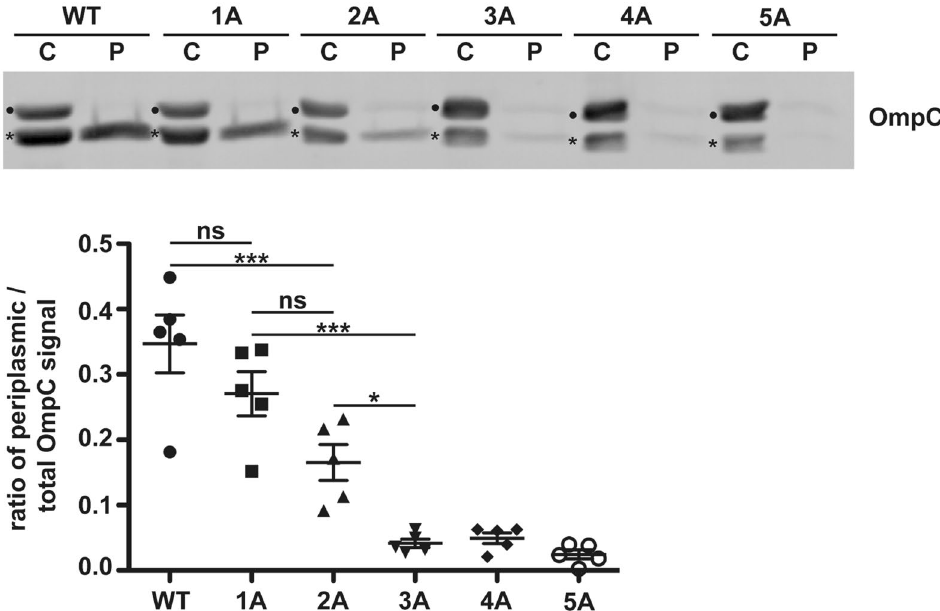
Figure 4. SecY-mediated translocation of OmpC is dependent on the net charge of its conserved alpha helical domain. Transformed E. coli cells expressing the proteins indicated were fractionated and the cytoplasmic (C) and periplasmic (P) fraction analyzed by Western blotting. Unprocessed full length constructs ( constructs after signal peptide cleavage (*) are marked. Uncropped image of representative Western blot can be found in Supplementary Figure 4. Data represent the mean plus/minus SEM from n = 5 biological replicates. To analyze the distribution of datasets (parametric/non-parametric), Kolmogorov–Smirnov test were performed. For the comparison of more than two parametric datasets, one-way ANOVA was used. To correct for α-error inflation resulting from multiple comparisons, ANOVA Dunnett’s post hoc multiple comparison test was